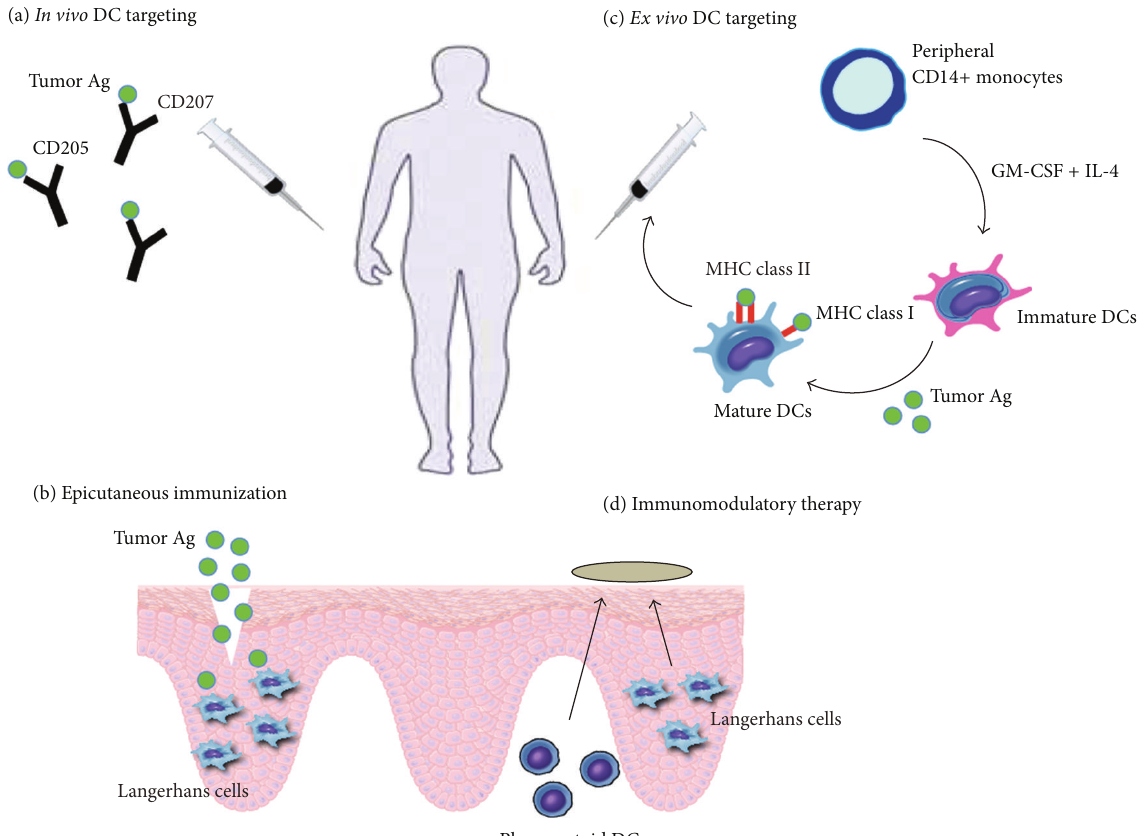
Figure 3: Current strategies for DC immunotherapy in the treatment of cutaneous carcinoma. (a) Direct in vivo DC vaccination involves the targeted delivery of tumor antigen to DCs by linking them to antibodies specific for a given DC surface molecule. Examples include CD205 for mDCs or Langerin/CD207 for LCs. (b) Epicutaneous immunization allows for the direct application of protein antigen to a disruption in the skin barrier, which will preferentially target LCs due to their predominance in the epidermis. (c) Ex vivo DC vaccination relies on the in vitro generation of immature DCs from hematopoietic progenitors or peripheral blood monocytes. DCs are then loaded with tumor antigen and reinfused into the patient. (d) Immunomodulatory therapy involves the application of topical agents that may directly regulate the immune response. Often they act as adjuvants to induce the activation and migration of LCs to nearby lymph nodes. Other effects include the TLR7/8-dependent recruitment of pDCs to the tumor region following imiquimod